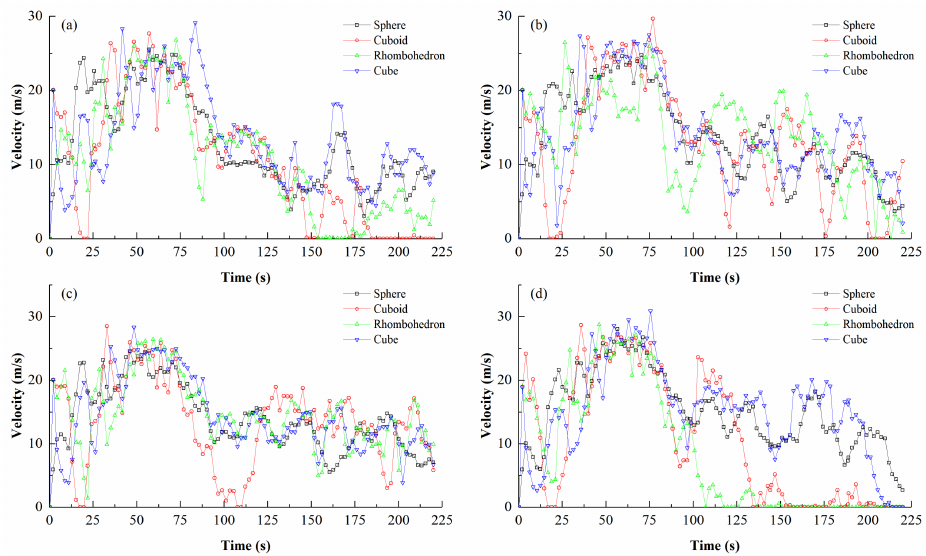
Figure 8. Influence of boulder shape on movement velocity under different density conditions: ( a ) ρ = 1200 kg/m 3 , ( b ) ρ = 1500 kg/m 3 , ( c ) ρ = 1800 kg/m 3 , and ( d ) ρ = 2100 kg/m 3